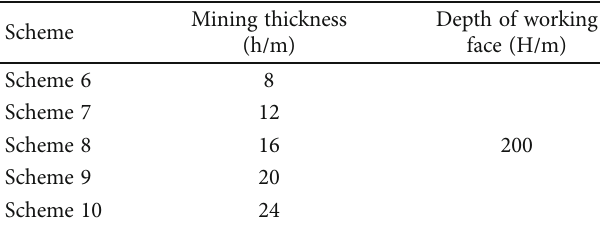
Table 3: In fl uence of mining thickness calculation